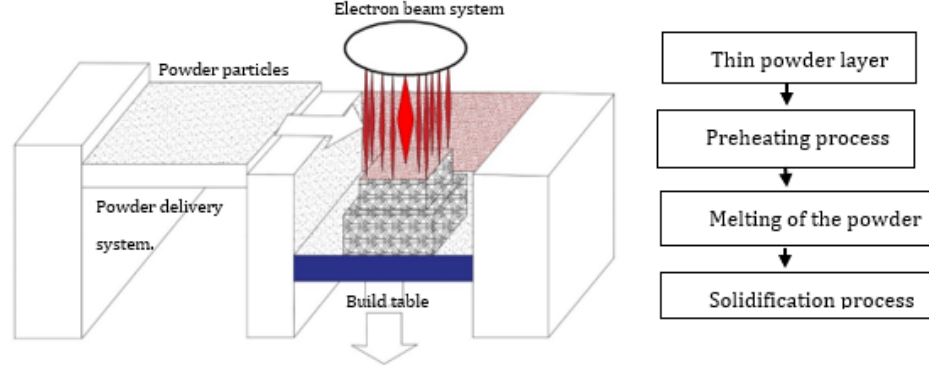
Figure 2. Schematic representation of the EBM manufacturing system.